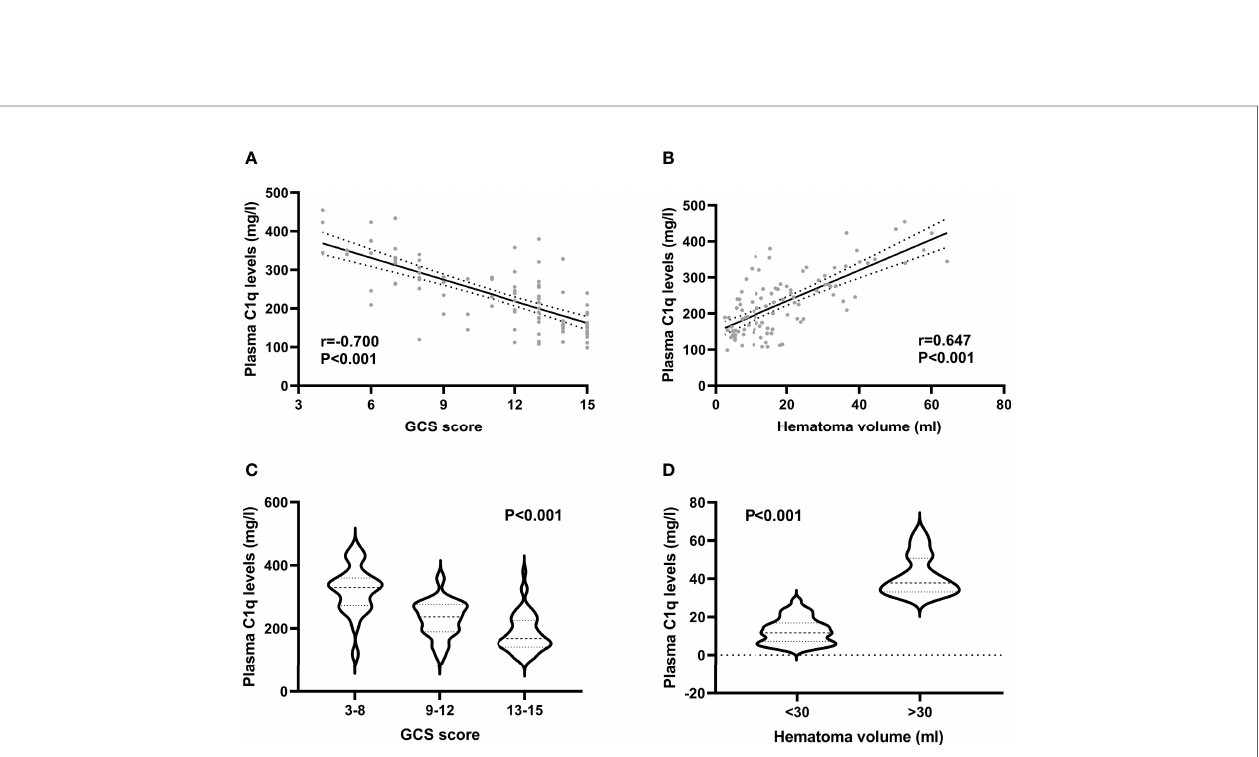
FIGURE 3 | Relationship between plasma C1q levels and hemorrhagic severity after acute intracerebral hemorrhage. (A) Relationship between plasma C1q levels and Glasgow Coma Scale score after acute intracerebral hemorrhage. Plasma C1q levels were tightly correlated with Glasgow Coma Scale score following stroke using the Spearman ’ s correlation coef fi cient (P < 0.001). GCS indicates Glasgow Coma Scale. (B) Differences of plasma C1q levels by hematoma volume after acute intracerebral hemorrhage. There were substantial differences in terms of plasma C1q levels after stroke among multiple groups using the Kruskal − Wallis test (P < 0.001). (C) Comparisons of plasma C1q levels across severity grade among patients with acute intracerebral hemorrhage. Signi fi cant differences of plasma C1q levels existed after stroke among multiple groups using the Kruskal − Wallis test (P < 0.001). GCS indicates Glasgow Coma Scale. (D) Relation of plasma C1q levels to hematoma volume after acute intracerebral hemorrhage. Plasma C1q levels were closely correlated with hematoma volume after stroke using the Spearman ’ s correlation coef fi cient (P <